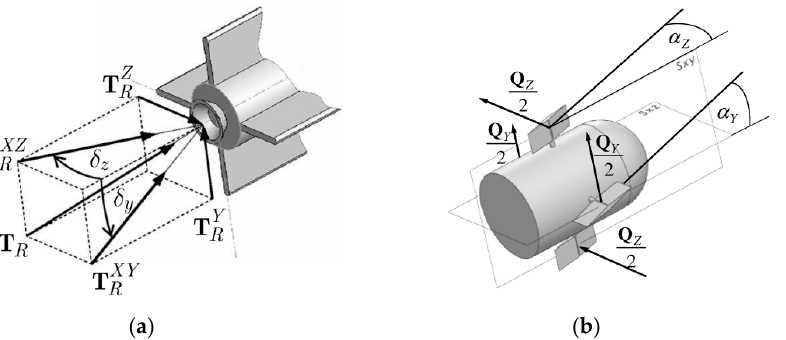
Figure 2. Generation of control forces while ( a ) tilting the engine nozzle; ( b ) deflection angles of aerodynamic control surface.